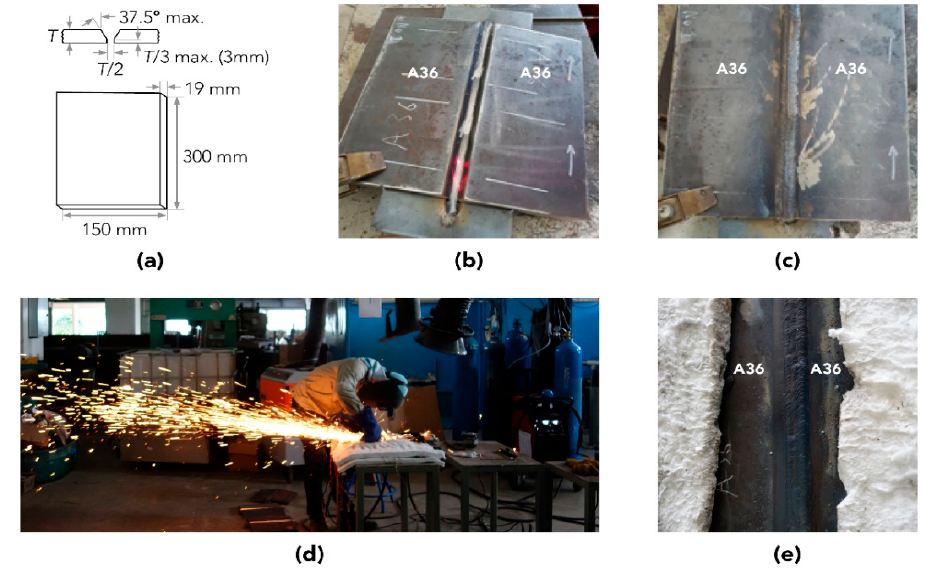
Figure 1. The substrate specimen preparation process: ( a ) Specimen dimensions; ( b ) A36—A36 specimens; ( c ) A36—A36 welded plate; ( d ) Welding processes; ( e ) Post-weld heat treatment.